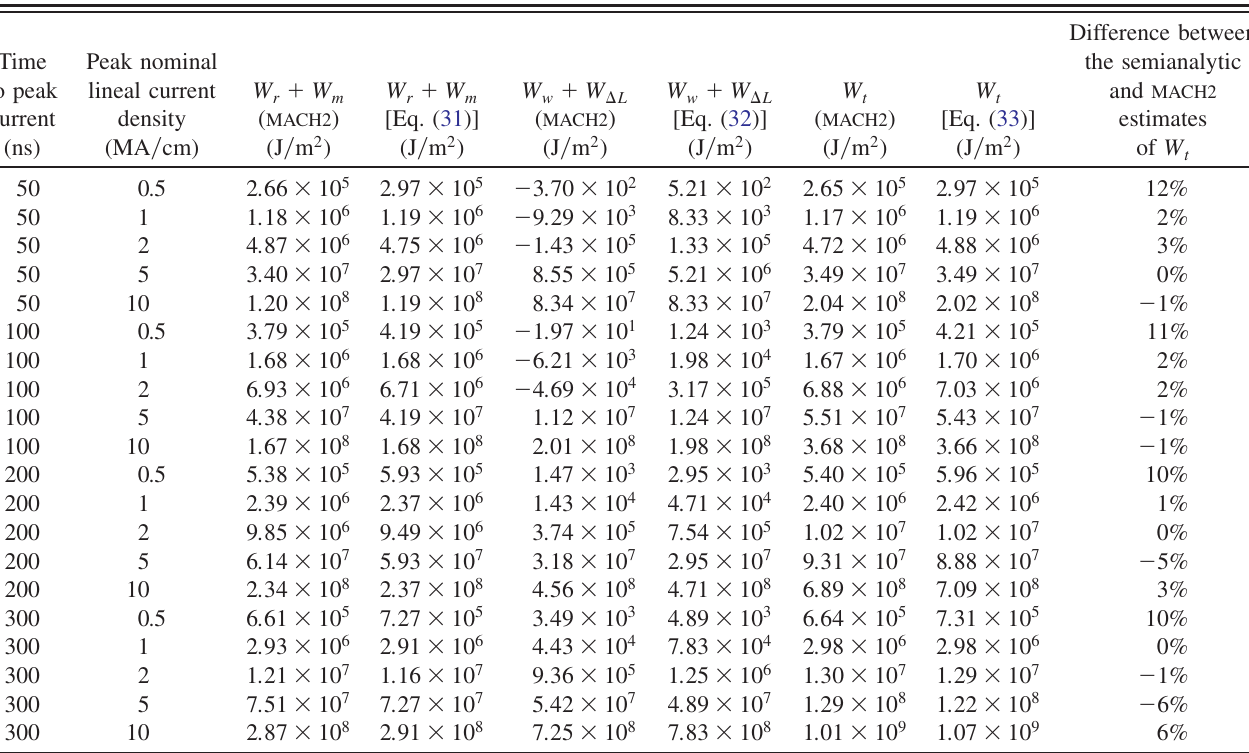
þ W given by Eq. (32) predicts a w (cid:2) L þ W . As suggested by the last three columns, the total energy loss W given by r m t